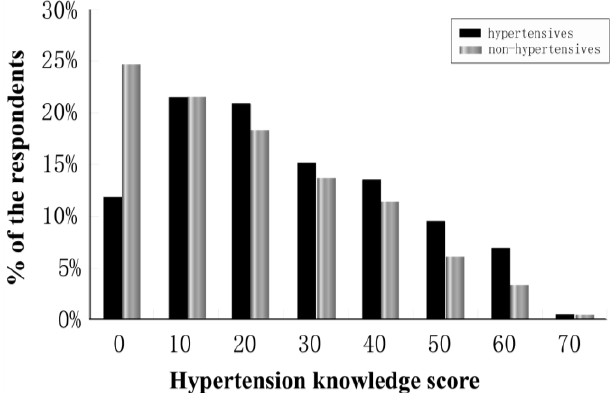
Figure 1. Percentage of the survey respondents by hypertension knowledge score (the maximum of 100).